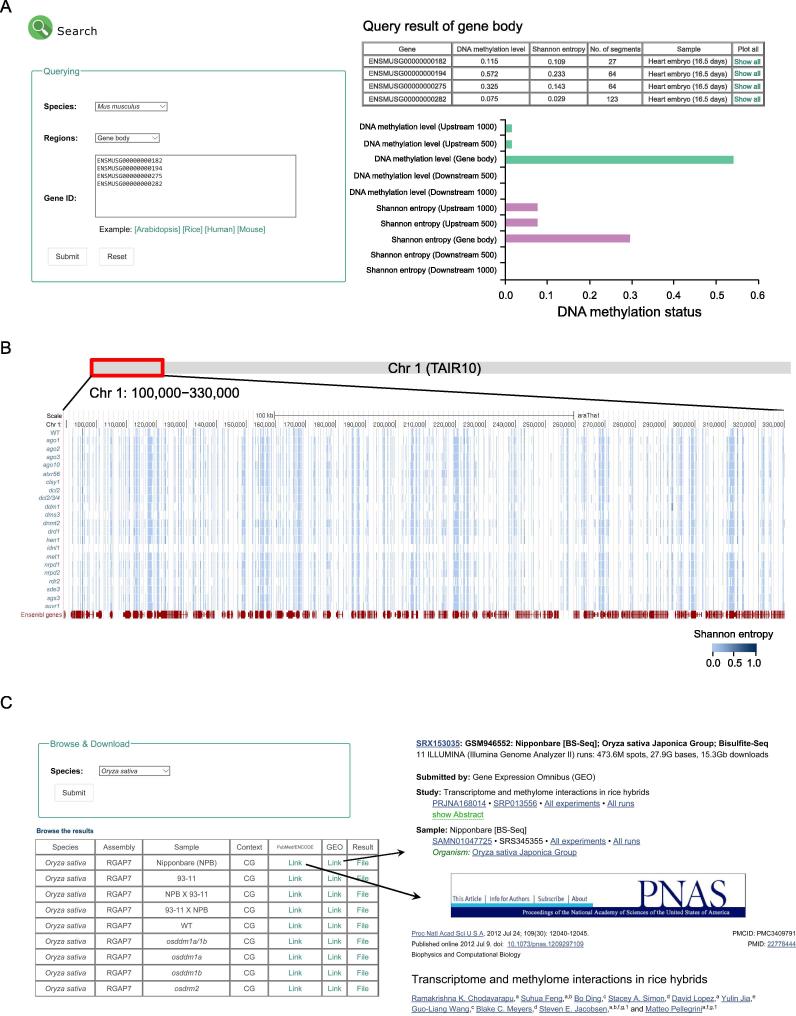
The interface of HeteroMethA. After submitting a list of gene IDs, the DNA methylation level and Shannon entropy for each gene can be browsed and downloaded. B. The landscapes of heterogeneity in DNA methylation in the wild type Arabidopsis and mutants are shown in the UCSC Genome Browser. A genomic region of Arabidopsis chromosome 1 (Chr 1: 100,000–330,000) is shown. A color gradient from light blue (Shannon entropy = 0) to dark blue (Shannon entropy = 1) shows the magnitude of heterogeneity in DNA methylation. C. HeteroMeth provides links to the associated publications or ENCODE experiment ID, and the accession numbers in GEO. Processed HeteroMeth data are also available for downloading.